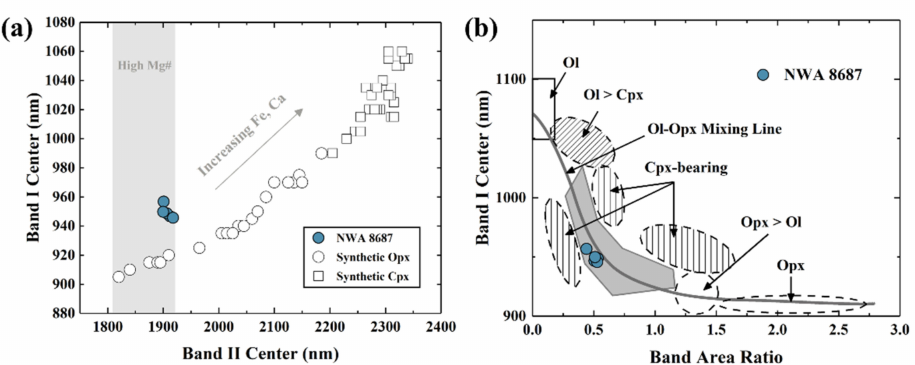
Figure 9. ( a ) Plot of the Band I center versus the Band II center. The laboratory pyroxene spectra are from Ref. [58]. ( b ) Plot of the Band Area Ratio versus the Band I center. The olivine–orthopyroxene mixing line is represented by the solid line. Different spectral regions are defined by Refs. [37,59].